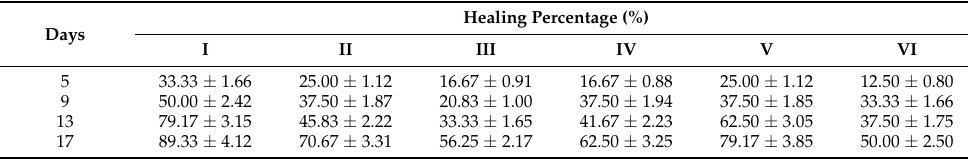
Healing Percentage